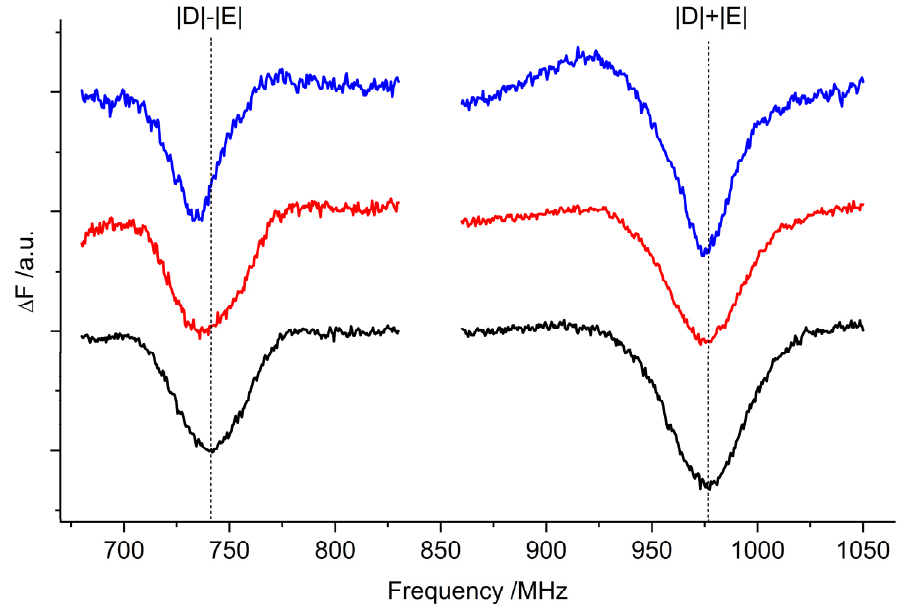
Figure 5. 3 Chl a FDMR spectra of the WT (black), lut2 (red), and lut2 npq2 (blue) LHCII variants detected at 690 nm. Amplitude modulation frequency: 33 Hz; temperature: 1.8 K.